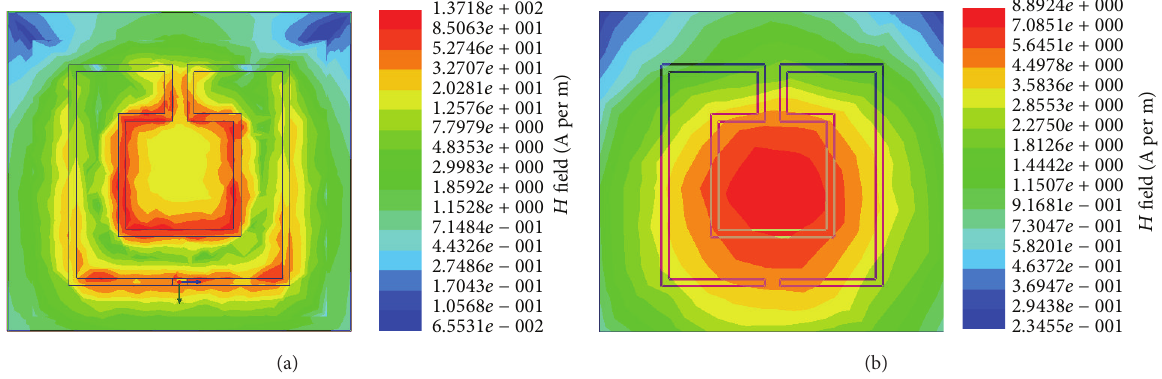
Figure 6: Magnetic field distribution Hz at (a) 𝑧 = 0 mm and (b) 𝑧 = 10